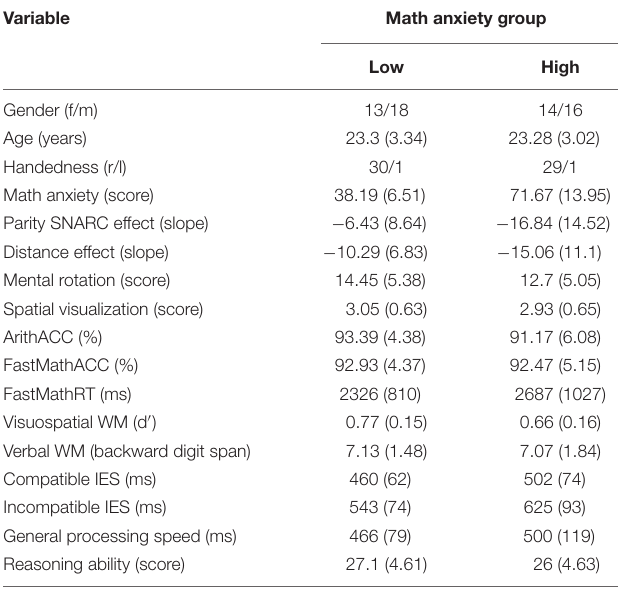
TABLE 2 | Descriptive information for the low and high math anxiety